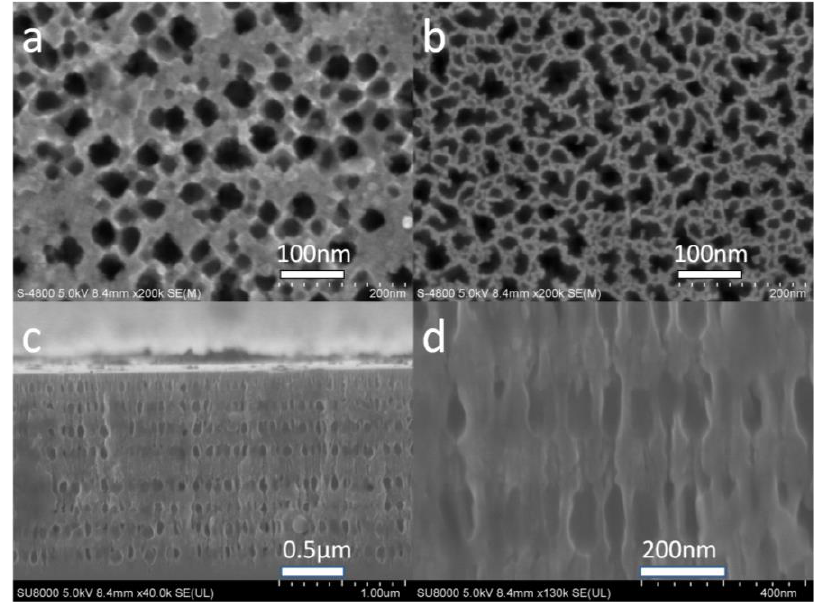
Figure 2. Scanning electron microscopy image ( a ) subjected to a corrosion current 14 mA and ( b ) subjected to a corrosion current 28 mA; ( c ) cross-sectional view of the PSM; ( d ) an enlarged view of the cross section.